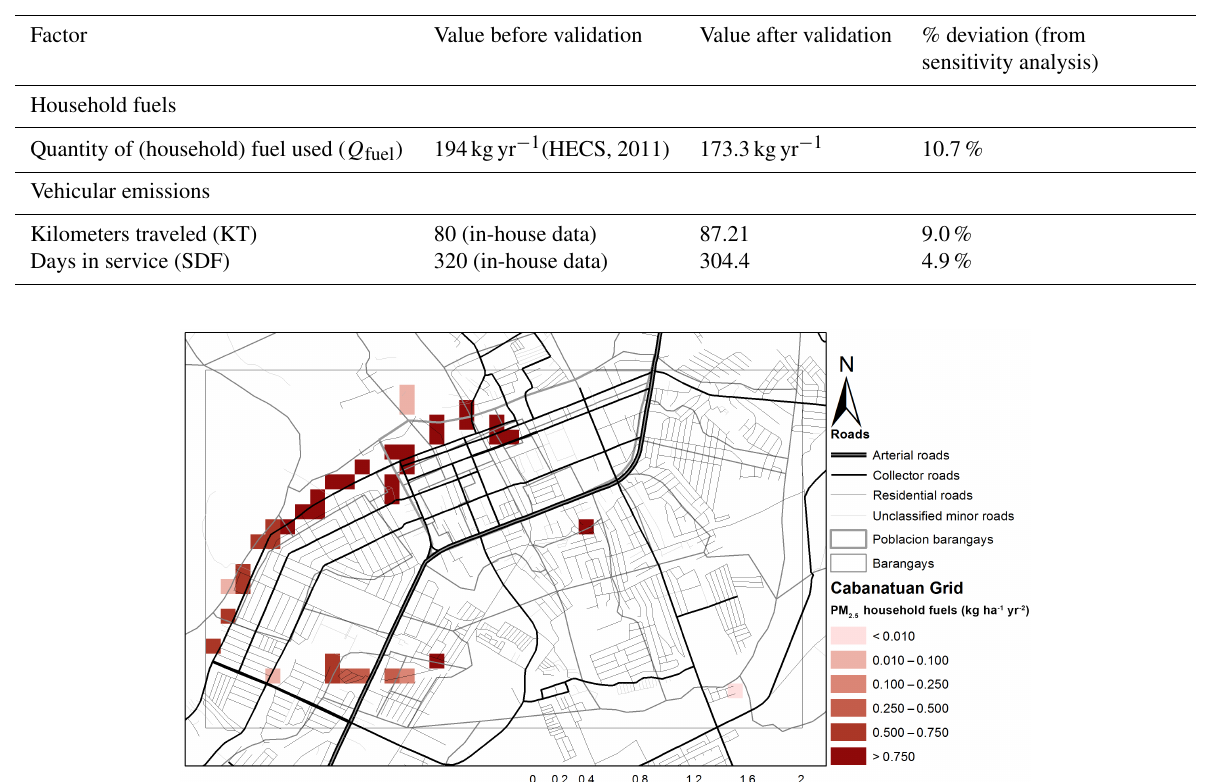
Table 3. List of activity data factors validated by ground survey sensitivity analysis.